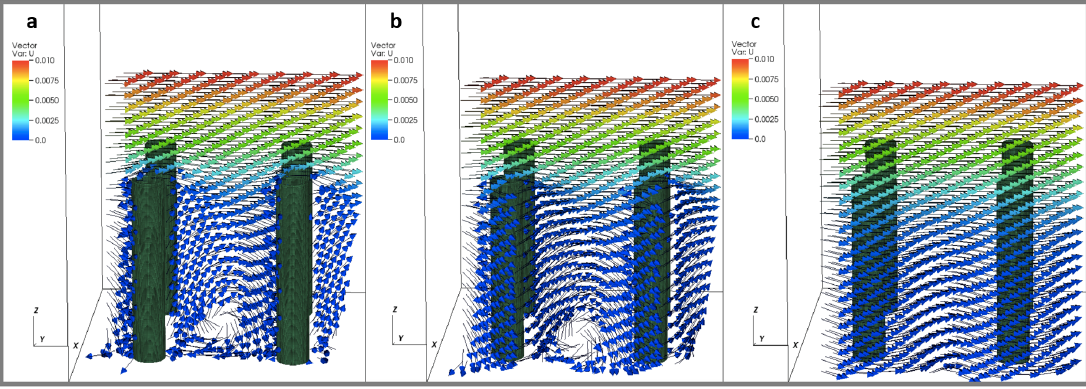
Figure 7. Velocity vectors taken within planes parallel to the direction of flow at Re = 1 ( Re d = 0.03125). The planes are taken through the center of the cylinder ( a ), one diameter from the center of a cylinder ( b ), and halfway between rows of cylinders ( c ). The height of the cylinders were set to 0.156, such that H / D = 5 and G / D =